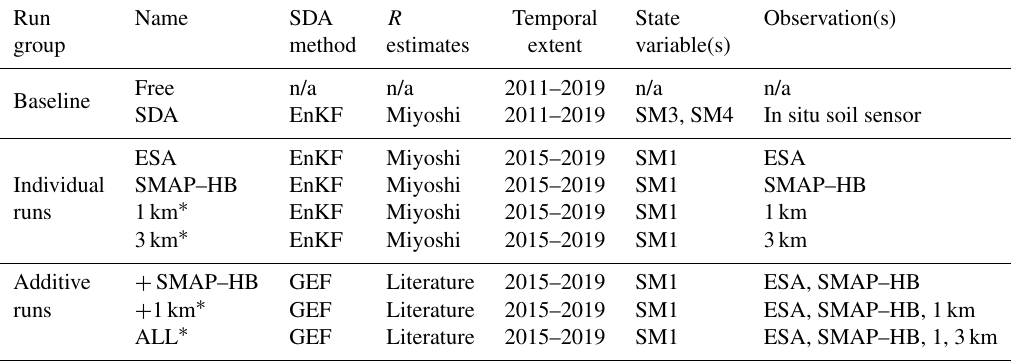
Table 2. Overview of system configuration for the nine runs performed in this study. SDA methods include the ensemble Kalman filter (EnKF) coupled with the Miyoshi algorithm and the generalized ensemble filter (GEF). The former method of these two methods provided systematic estimates of R applied within the system, but the latter method used literature values. The state variables included in X f are given.